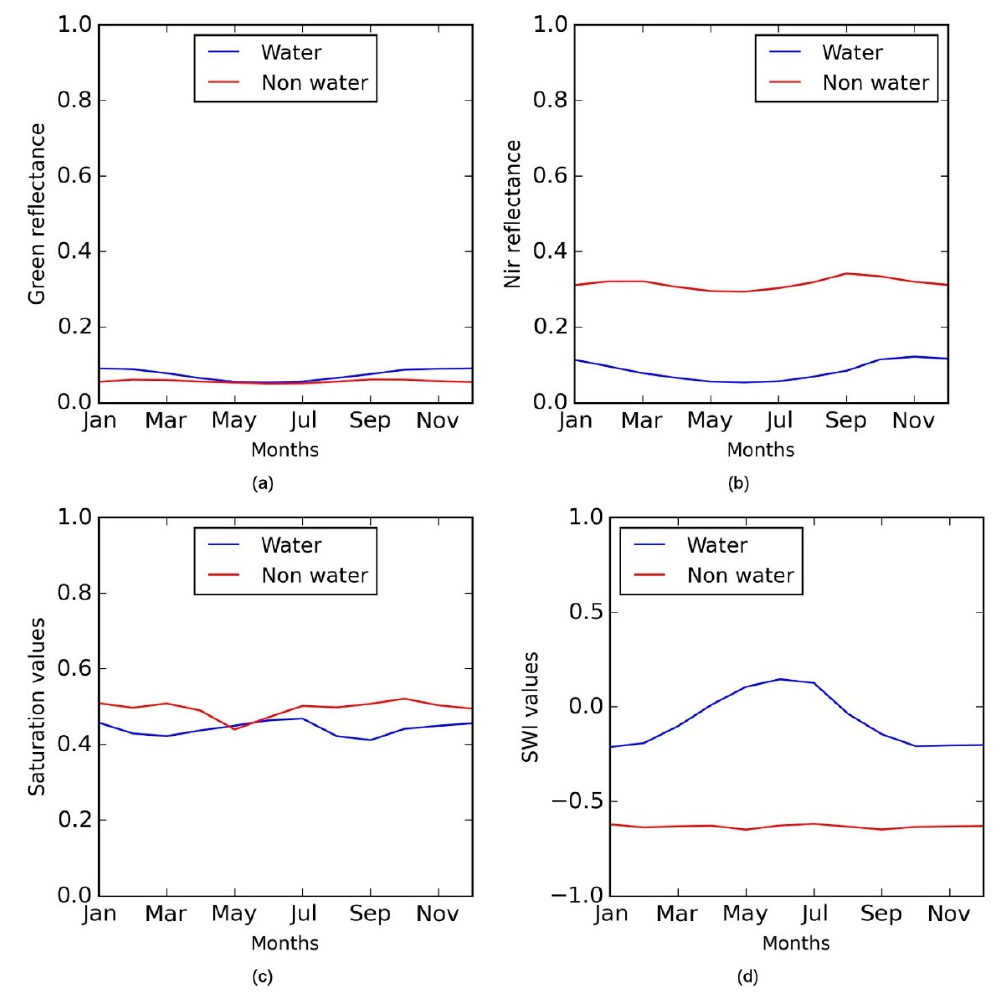
Figure 11. Monthly variation of different parameters over the water and non-water areas in a wet region: ( a ) Green reflectance, ( b ) Near infrared reflectance, ( c ) Saturation values, ( d ) Superfine Water Index (SWI)